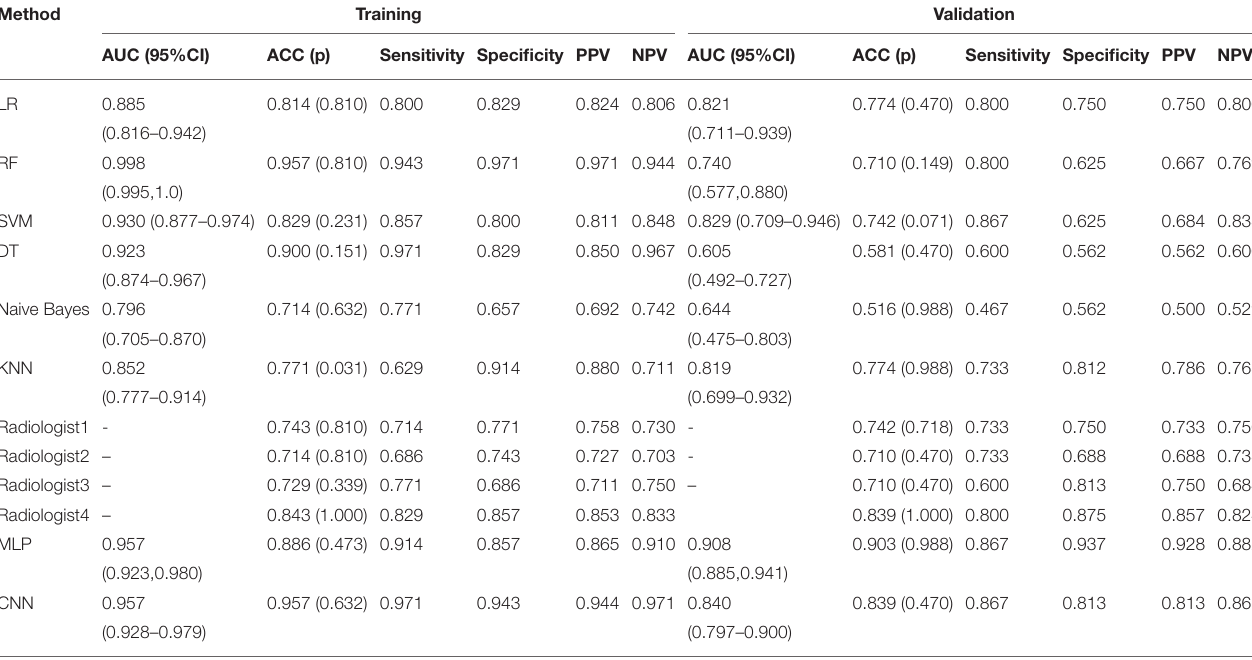
TABLE 2 | Performance of different models in training set and validation set.